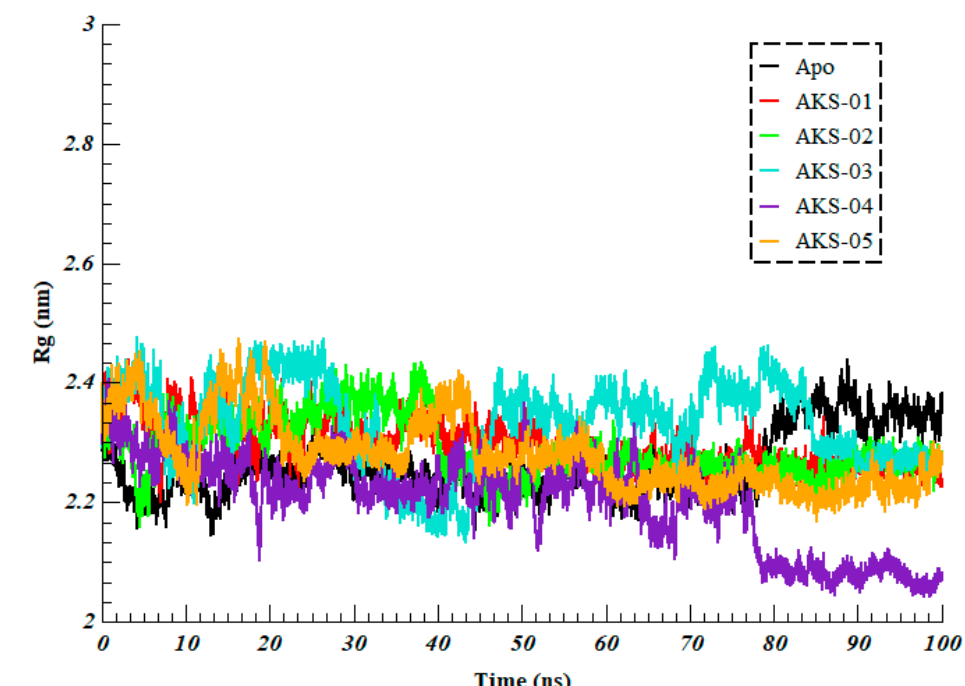
Figure 7. Radius of Gyration of Apo (Omicron’s RBD) and five selected compounds in complex with RBD over the 100 ns of simulation time.